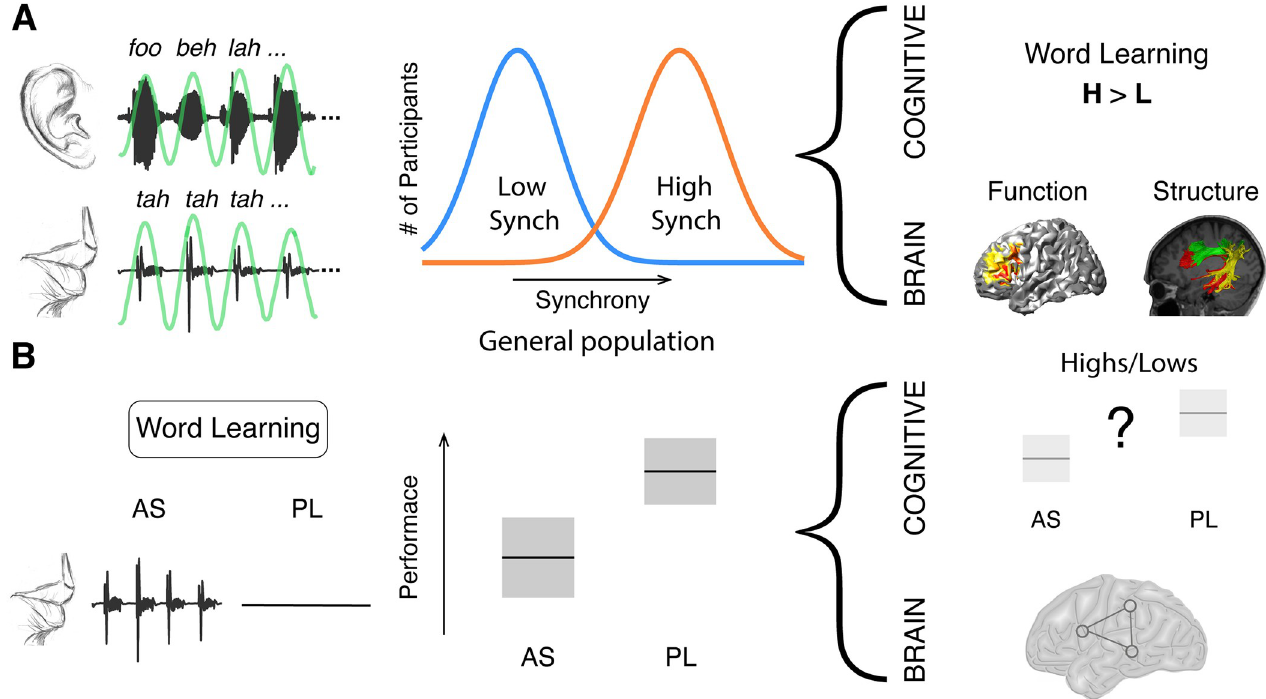
Fig 1. Previous work motivating the hypothesis. (A) During the SSS test, participants listen to an isochronous stream of random syllables (rate 4.5 syllables/ sec) while concurrently whispering the syllable “tah.” Left panel: example of the perceived (upper panel) and produced (lower panel) signals. Green line, band- pass filtered envelope used to compute input-output synchrony. Middle panel: Synchrony between perceived and produced syllables yields a bimodal distribution, allowing the classification of participants into low (blue) and high (orange) synchronizers. While some participants spontaneously align the produced syllabic rate to the perceived one (high synchronizers), others show no modification of the produced rate due to the presence of the external rhythm (low synchronizers). Right panel: High synchronizers outperformed lows in a statistical word learning task. They also showed enhanced brain-to-speech synchronization over left frontal regions and a greater volume in the white-matter pathways connecting temporal and frontal areas [18]. (B) The word learning task consists of a learning phase wherein 4 trisyllabic pseudo-words are presented in a continuous stream. Learning is assessed post exposure. Left panel: Participants are instructed to repeat a nonsense syllable (AS condition) or to passively listen (PL condition) during the entire learning phase. Middle panel: predicted performance decreases due to AS [9]. Right panel: differences between high and low synchronizers are hypothesized at the cognitive and brain levels. A AU : AbbreviationlistshavebeencompiledforthoseusedthroughoutFigs 1 (cid:0) 5 : Pleaseverifythatallentriesarecorrect : S, articulatory suppression; PL, passive